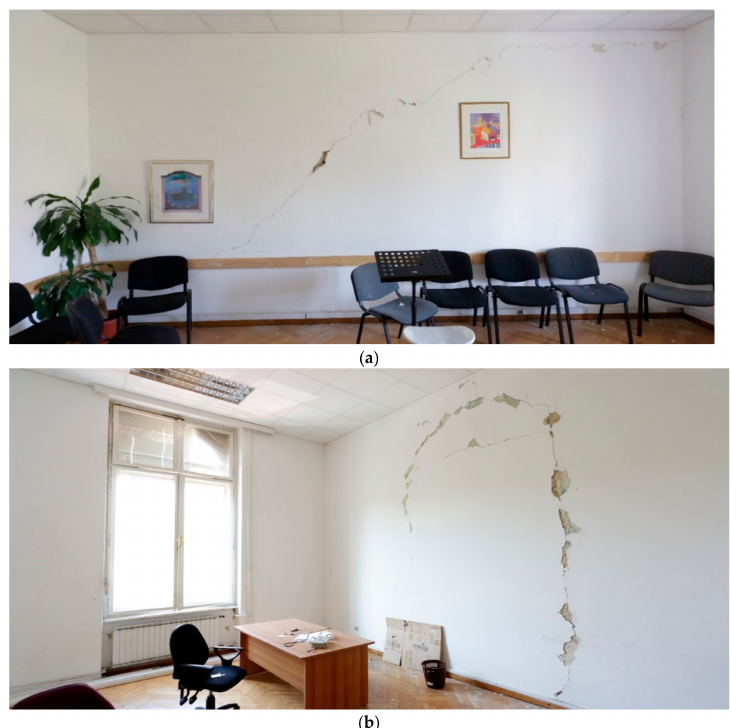
Figure 9. Cracks on load-bearing walls ( a ) and cracks on walls where previous interventions were made such as bricked-up doors and above the openings ( b ) on the 3rd floor. All damage that is found in the building is photographed and described. Besides that, every type of damage is plotted in the building’s 3D schemes according to their severity (Figures 10–13). The green color (smaller damage) represents all types of damage where there is no need for a detailed check-up. Small local damage of plaster, local cracking on walls where the openings were bricked up, very thin cracks etc., fall into this category. The yellow color (medium damage) represents all types of damage where the plaster should be removed, and a detailed check-up is needed such as for the diagonal cracking of load bearing walls and severe cracks on parapet walls. In the end, the red color (severe damage) represents severe damage of structural elements where retrofitting methods must be used. This way, how the building behaved during the earthquake may be obtained.